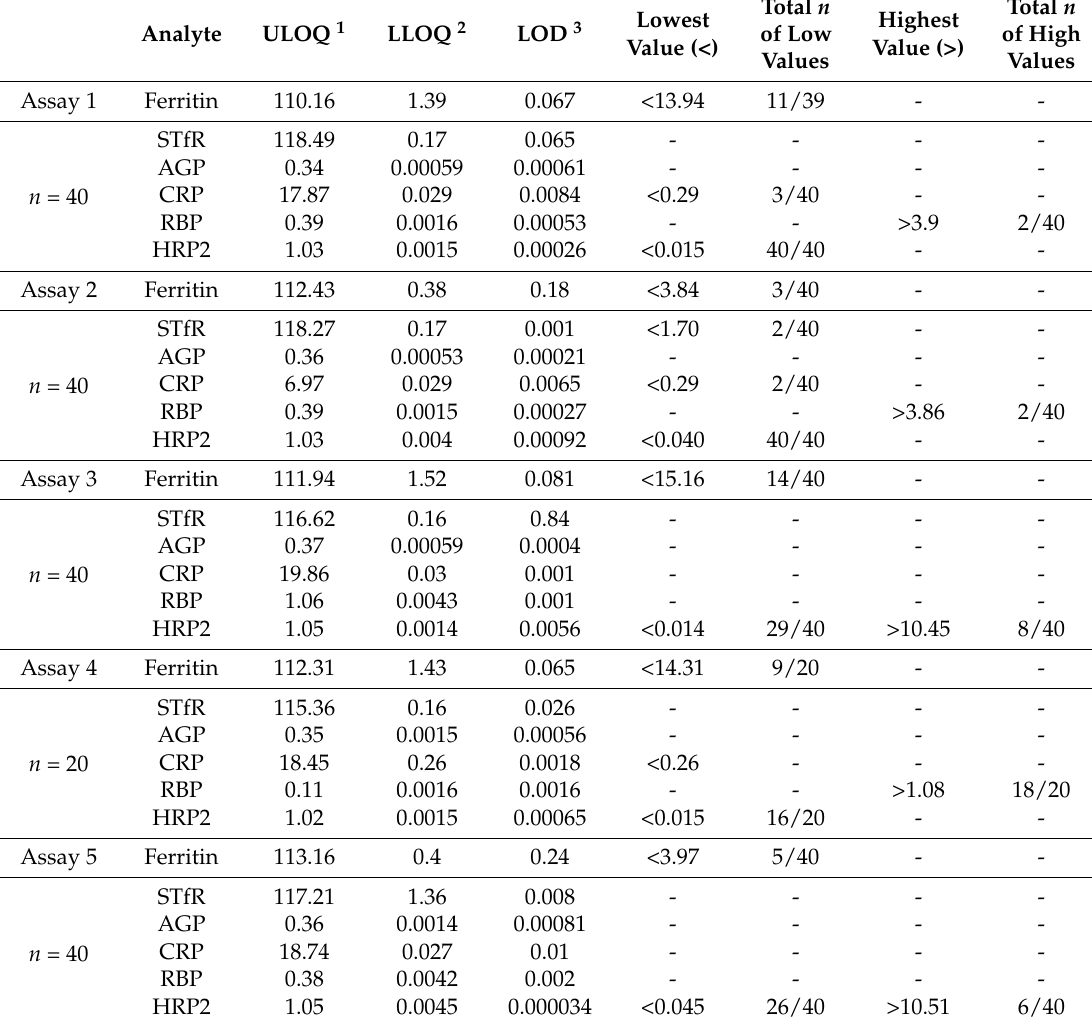
Table 2. Quality control data for the Quansys enzyme-linked immunosorbent assay (ELISA) for each of the five assays conducted (total n =